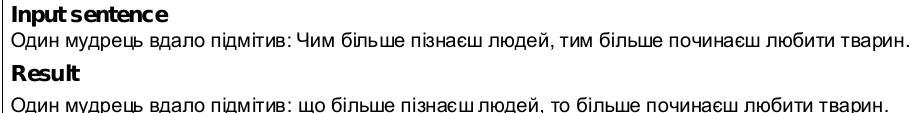
Figure 14. Creativity of the neural network. Figure 15. Correction of Surzhyk by the neural network.